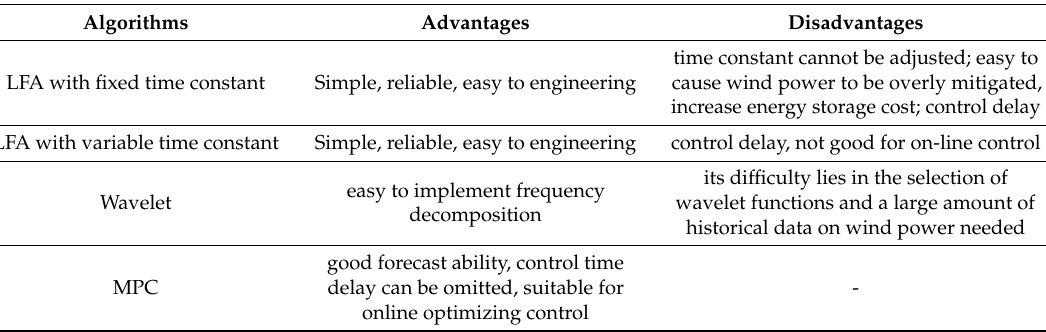
Table 1. The advantages and disadvantages of the algorithms.